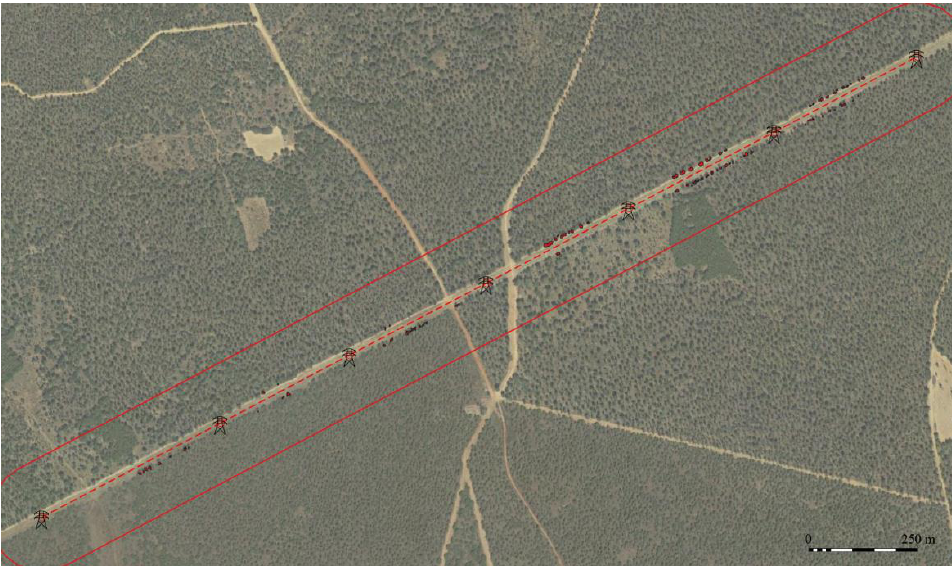
Figure 8. Risk areas obtained with public airborne LiDAR data using the approach based on the theoretical catenary using the maximum sag hypothesis.